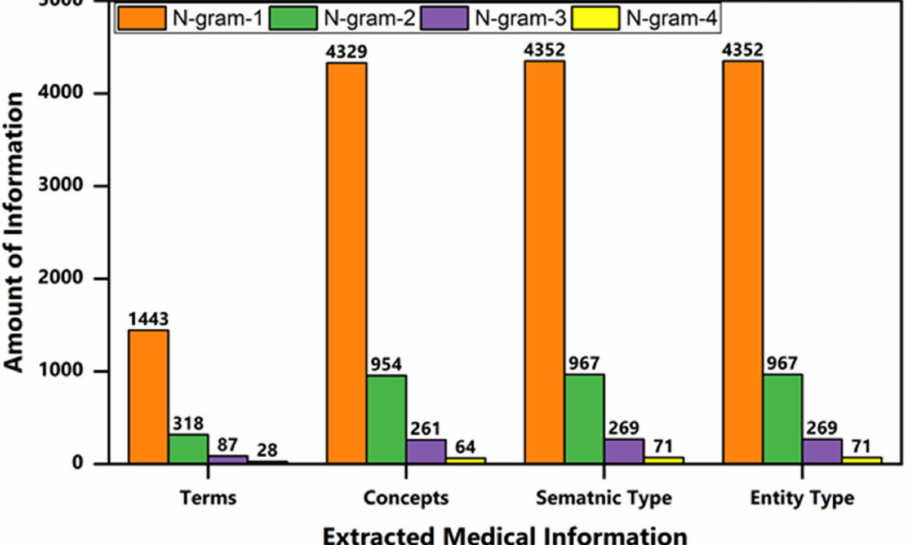
Figure 6. UMLS semantic breakdown using n-gramming strategies with n =